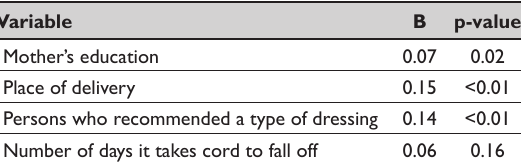
Table 4: Results of multiple logistic regression analysis predicting type of substances